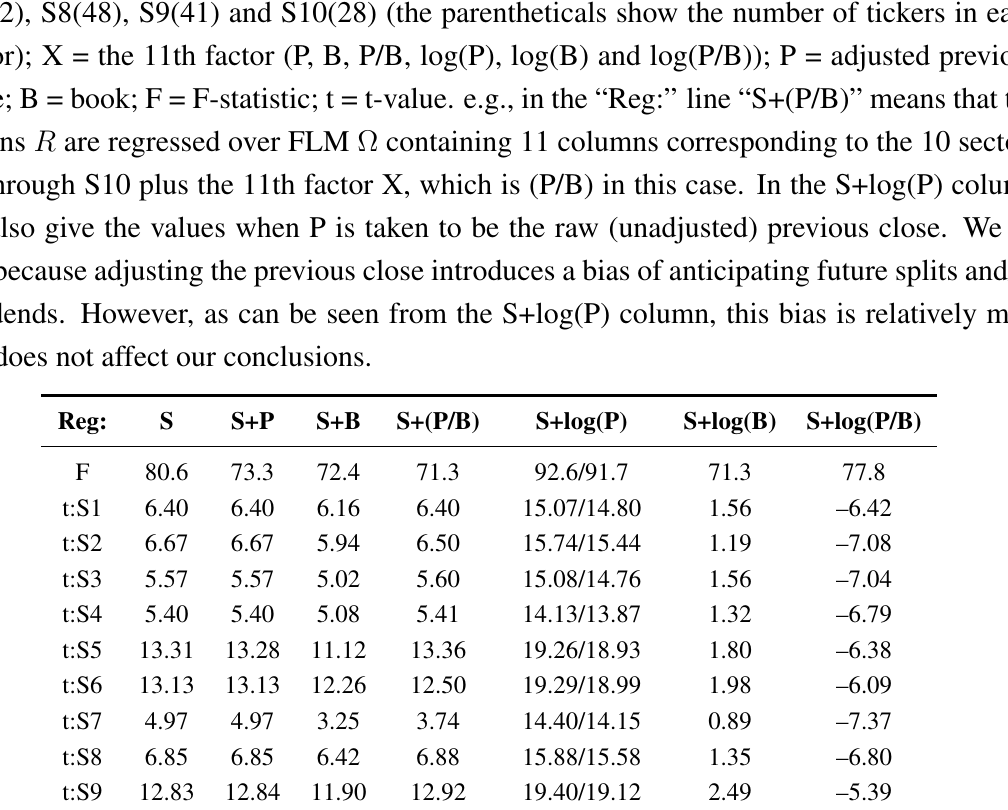
Table 2. Results for regressions (56) and (57) with the BICS-sector 10-factor model as the benchmark. S = 10 BICS sectors labeled by S1(30), S2(63), S3(45), S4(30), S5(91), S6(75), S7(42), S8(48), S9(41) and S10(28) (the parentheticals show the number of tickers in each sector); X = the 11th factor (P, B, P/B, log(P), log(B) and log(P/B)); P = adjusted previous close; B = book; F = F-statistic; t = t-value. e.g., in the “Reg:” line “S+(P/B)” means that the returns R are regressed over FLM Ω containing 11 columns corresponding to the 10 sectors